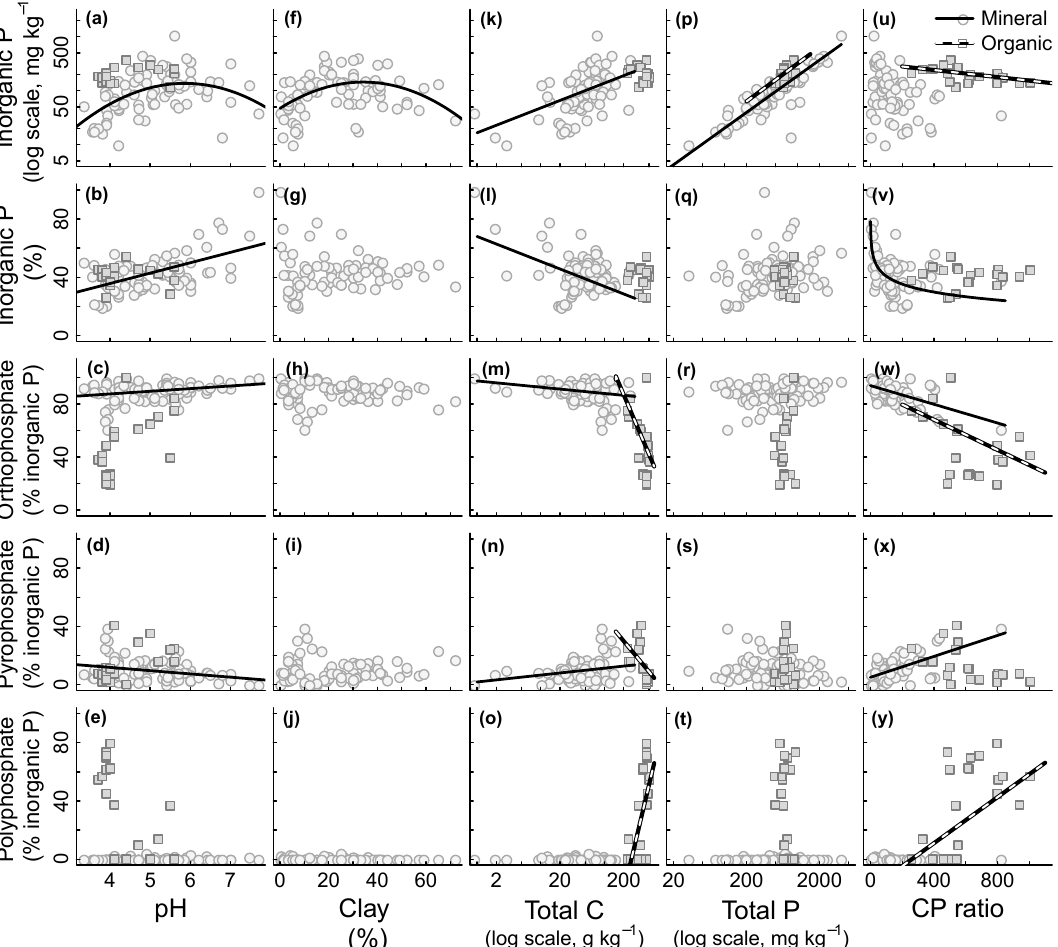
Figure 2. Relationship between edaphic properties and soil inorganic phosphorus (P) composition in NaOH-EDTA extract from soil mineral and organic layers on natural ecosystems. Note that the reported total P is the one obtained by digestion and usually comprise the residual P non-recovered by the NaOH-EDTA extractant. Regression models ( n = 80 mineral layer and n = 20 mineral layer): mineral layer, log(total P i mgkg − 1 ) = − 1 . 62 + 1 . 28pH − 0 . 11pH 2 , r 2 = 0 . 33; mineral layer, total P i (%) = 7 . 21 + 7 . 12pH, r 2 = 0 . 34; mineral layer, orthophosphate = 79 . 7 + 2 . 00pH, r 2 = 0 . 11; mineral layer, pyrophosphate = 20 . 8 − 2 . 23pH, r 2 = 0 . 11; mineral layer, log(total P i mgkg − 1 ) = 1 . 68 + 0 . 028